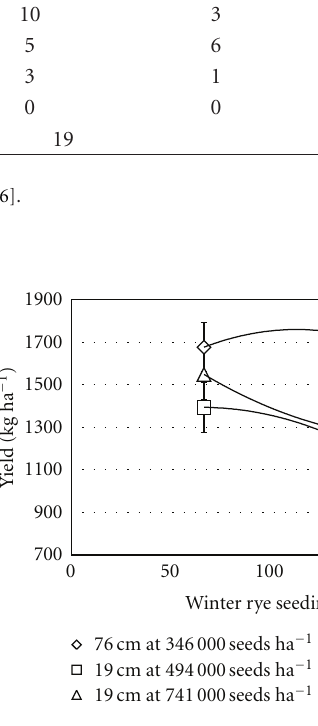
Figure 1: E ff ect of spring-interseeded winter rye rate on wide- (76- cm) and narrow-row (19-cm) soybean grain yield. Fitted lines are for wide rows (open diamonds, y = − 0 . 0382 x 2 + 8 . 6867 x + 1265 . 3, R 2 = 0 . 99), narrow rows at 494,000 seedsha − 1 (NRL, open squares, y = − 0 . 0301 x 2 + 3 . 949 x + 1263 . 8, R 2 = 0 . 99), and narrow rows at 741,000 seeds ha − 1 (NRH, open triangles, y = 0 . 0256 x 2 − 8 . 9692 x + 2033 . 8, R 2 = 0 . 99). The vertical bars represent the standard errors of the means. The weedy check grain yields were 790, 1000, and 1130 kgha − 1 in wide-row, NRL, and NRH systems,